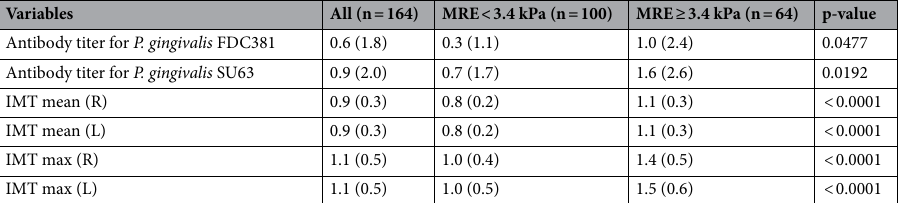
Table 2. Baseline characteristics of the trial population. ALP alkaline phosphatase, ALT alanine aminotransferase, AST aspartate aminotransferase, BMI body mass index, BOP bleeding on probing, CAP controlled attenuation parameter, CAL clinical attachment level, DPP4 dipeptidyl peptidase-4, EAA endotoxin activity assay, GGT gamma-glutamyl transferase, HDL-C high-density lipoprotein cholesterol, HOMA-R homeostasis model assessment-estimated insulin resistance, hsCRP high-sensitivity C-reactive protein, IMT (R: right, L: left) intima-media thickness (R, L), LDL-C low-density lipoprotein cholesterol, LSM liver stiffness measurement, MRE magnetic resonance elastography, MRI magnetic resonance imaging, PDFF proton density fat fraction, PPD periodontal pocket depth, T.Bil total bilirubin, Tcho total cholesterol, TG triglycerides, VCTE vibration-controlled transient elastography. a Data are reported as means (SDs) or numbers (percentages). P-values were determined using the t-test.